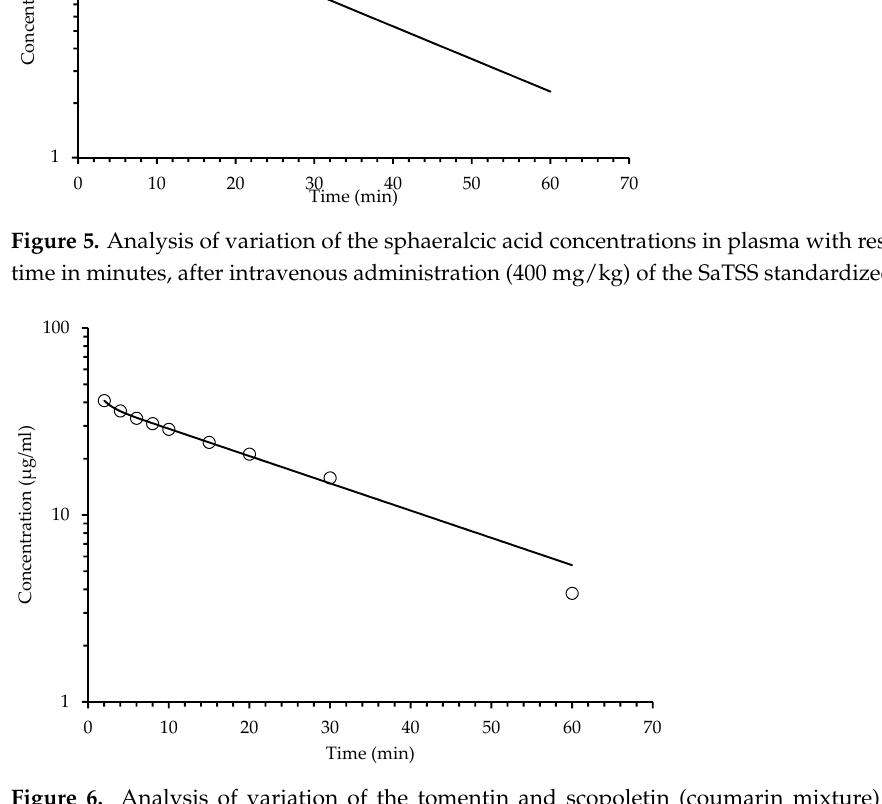
Figure 6. Analysis of variation of the tomentin and scopoletin (coumarin mixture) concentration in plasma with respect to time, after intravenous administration (400 mg/kg) of the SaTSS standardized fraction.